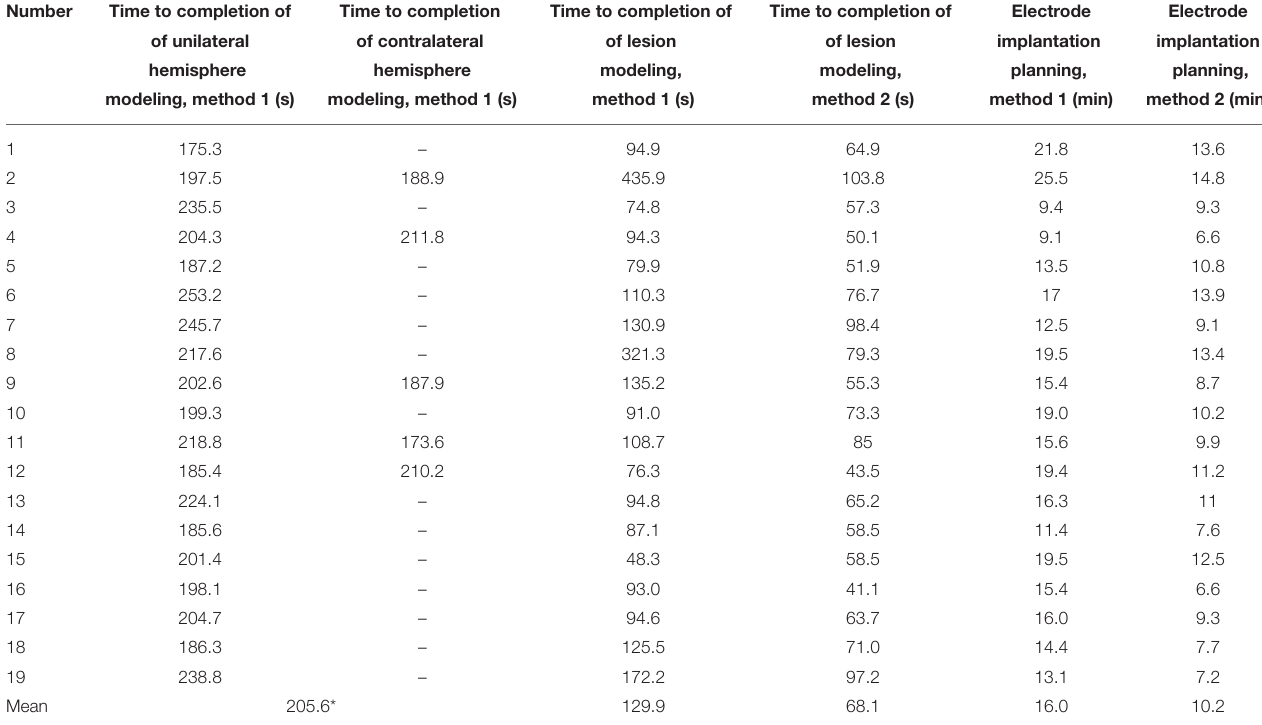
TABLE 2 | Time to model and complete electrode implantation planning using methods 1 and